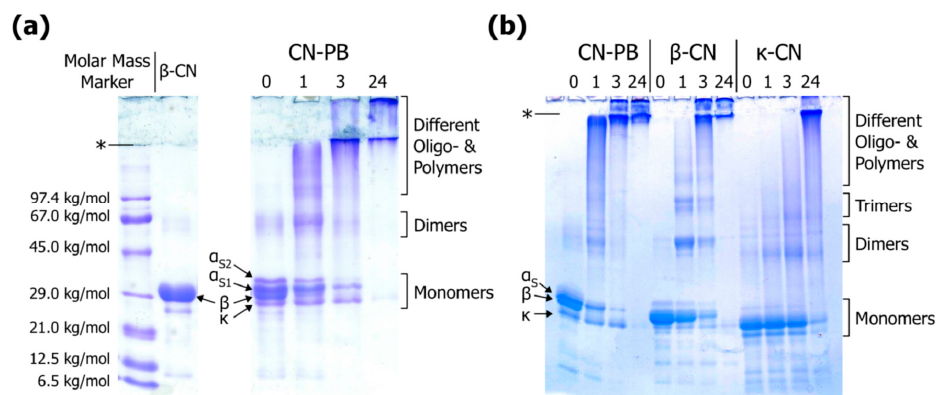
Figure 7. ( a ) Linear sodium dodecyl sulphate polyacrylamide gel electrophoresis (SDS-PAGE) of cross-linked casein in phosphate buffer (CN-PB) in comparison to uncross-linked β -casein ( β -CN) and a molecular weight marker (see Appendix A2 for experimental details); ( b ) Gradient SDS-PAGE of cross-linked CN-PB, β -CN, and κ -casein ( κ -CN) (originally presented in [94]; see also Appendix A3). The thresholds between stacking and separating gels are indicated by (*). Numbers refer to time (h) of cross-linking with transglutaminase (see Appendix